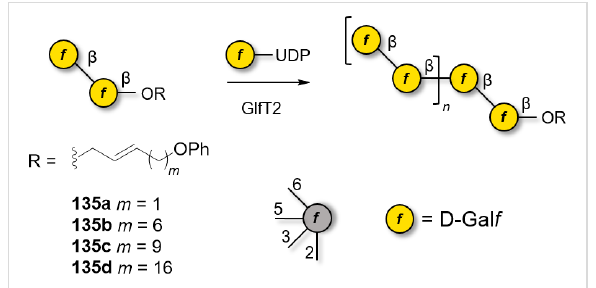
Figure 13: GlfT2 from Mycobacterium tuberculosis catalyzes the sequential addition of UPD-Gal f donor to a growing galactan chain composed of alternated β (1–5)- and β (1–6)-linked ᴅ -Gal f .